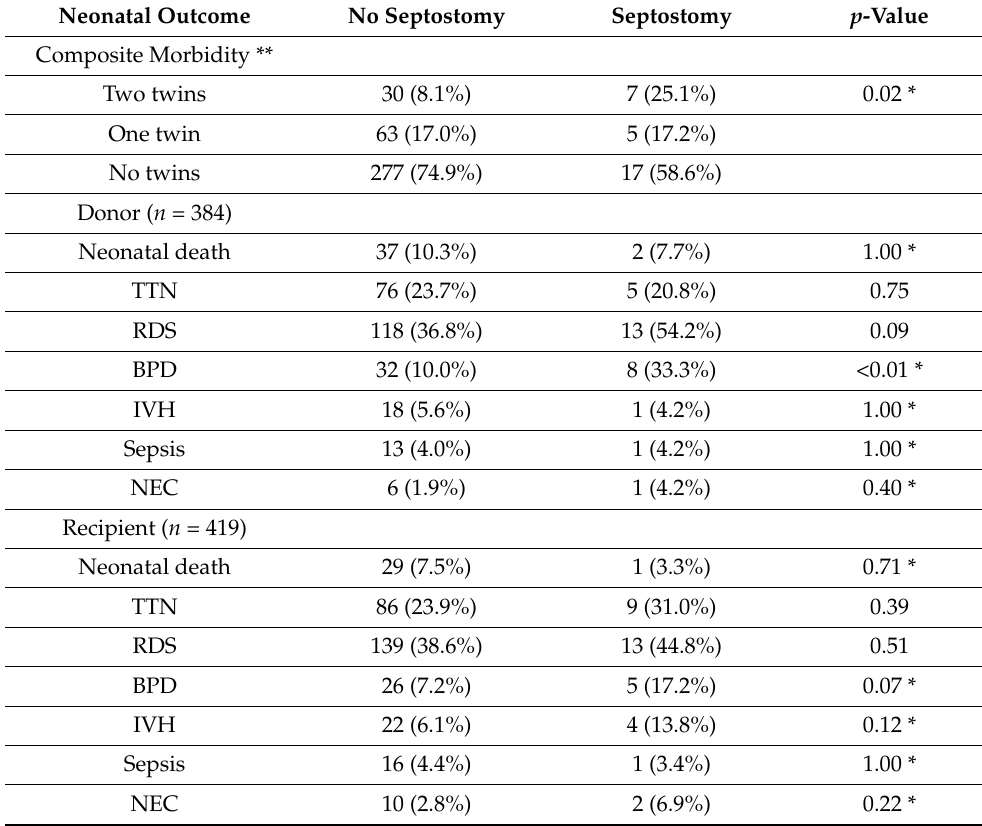
Figure 3. Flow chart showing neonates available for analysis. Table 4. Neonatal